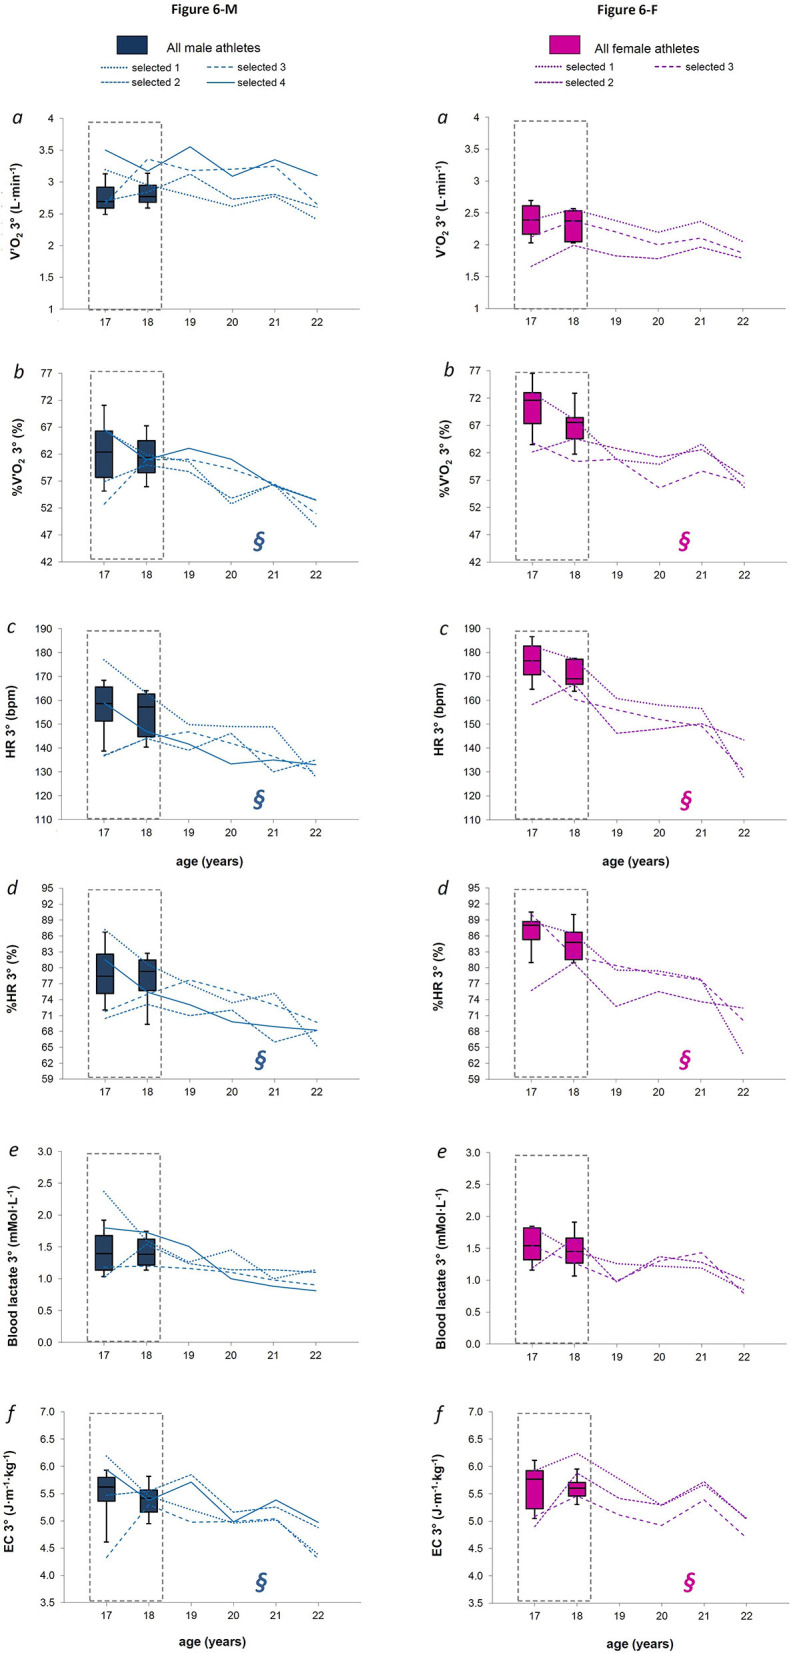
Figures 6-M and 6-F. For males and females (Figures 6-M and 6-F, respectively), the box plot represents medians, 9, 25, 75, and 90th percentiles of the values measured at 3° of treadmill incline (3°) for absolute oxygen consumption (panel a), relative oxygen consumption (panel b), absolute heart rate (panel c), relative heart rate (panel d), blood lactate concentration (panel e), and energetic cost of diagonal skiing (panel f) measured over the late teenage period (data in dotted-lined boxes) in the entire group. In each panel, the line plots represent each selected athlete from 18 to 22 years of age. § indicates a likely effect of age after the late teenage period.